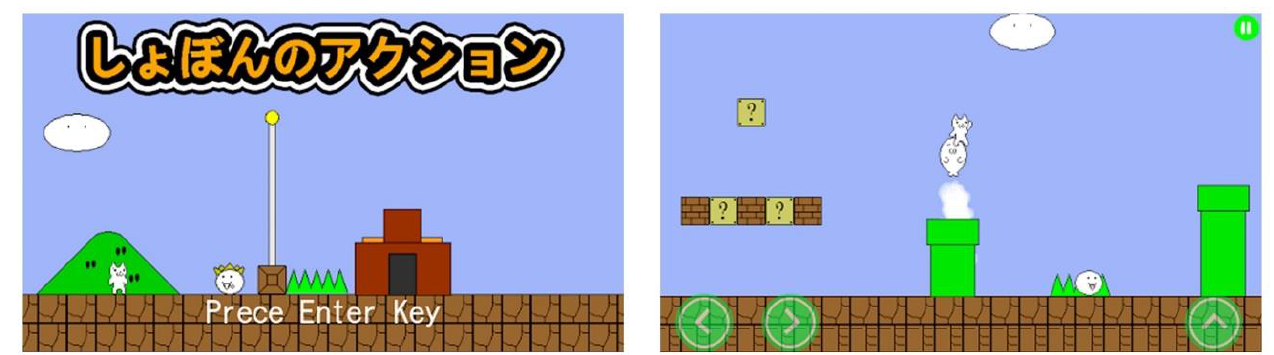
Fig. 2. Syobon action or cat Mario games are commonly known as frustrating games to play